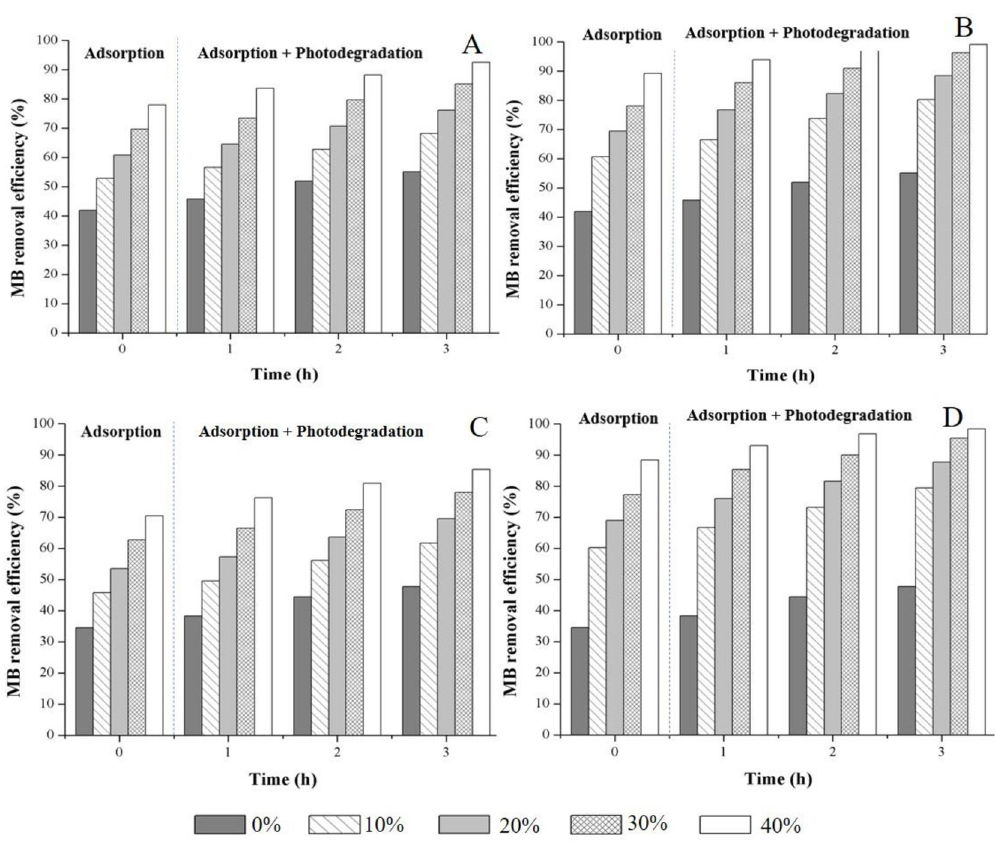
Fig 11. MB removal efficiency (at 40 mg/L) of powdered geopolymer composites containing different amounts of zeolite and TiO 2 /zeolite (A) fresh geopolymer composite containing zeolite, (B) fresh geopolymer composite containing TiO 2 / zeolite, (C) reused geopolymer composite containing zeolite and (D) reused geopolymer composite containing TiO 2 /